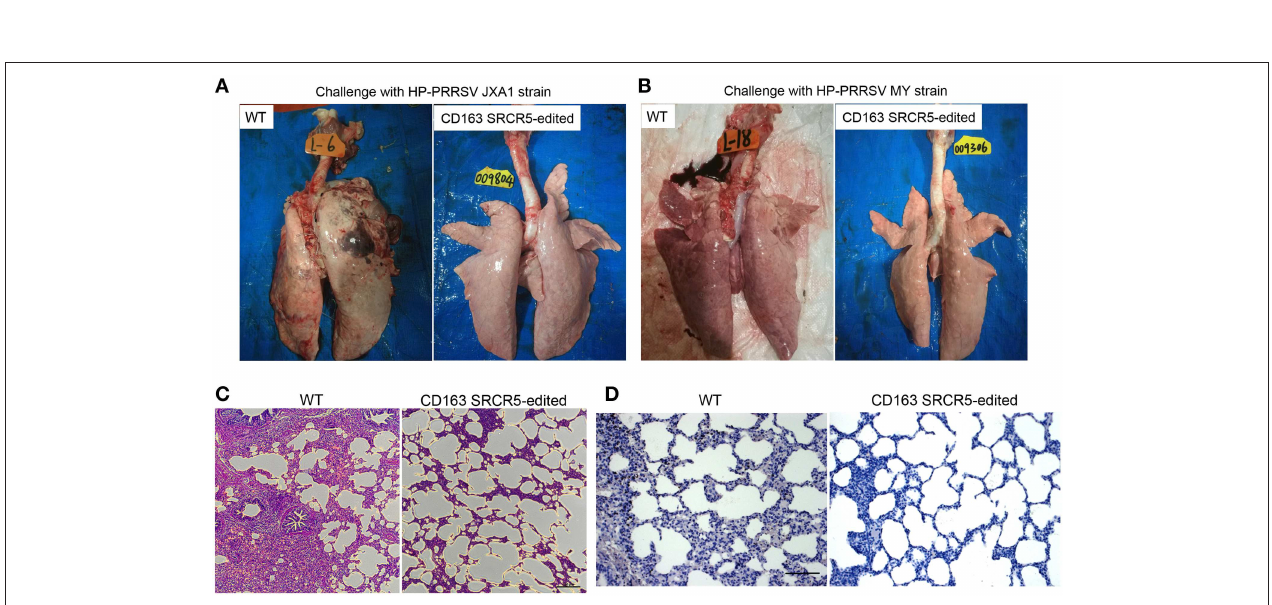
FIGURE 4 | CD163 SRCR5-edited pigs exhibit normal histopathology after PRRSV challenge. Lungs were isolated from CD163 SRCR5-edited and WT animals on day 42 post PRRSV challenge. Pathological changes of lung lesions were observed and assessed using visual examination, Hematoxylin and Eosin (H&E) staining and immunohistochemistry. (A,B) Photographs of the dorsal side of lungs from CD163 SRCR5-edited and WT animals challenged with PRRSV JXA1 (A) and MY (B) strains. (C) Lung paraffin sections were stained with H&E (scale bar, 100 µ m). (D) Immunohistochemistry analysis of the PRRSV antigen (brown) in lung paraffin sections (scale bar, 50 µ m). The macrophages stain intensely dark brown due to the presence of the PRRSV antigen.